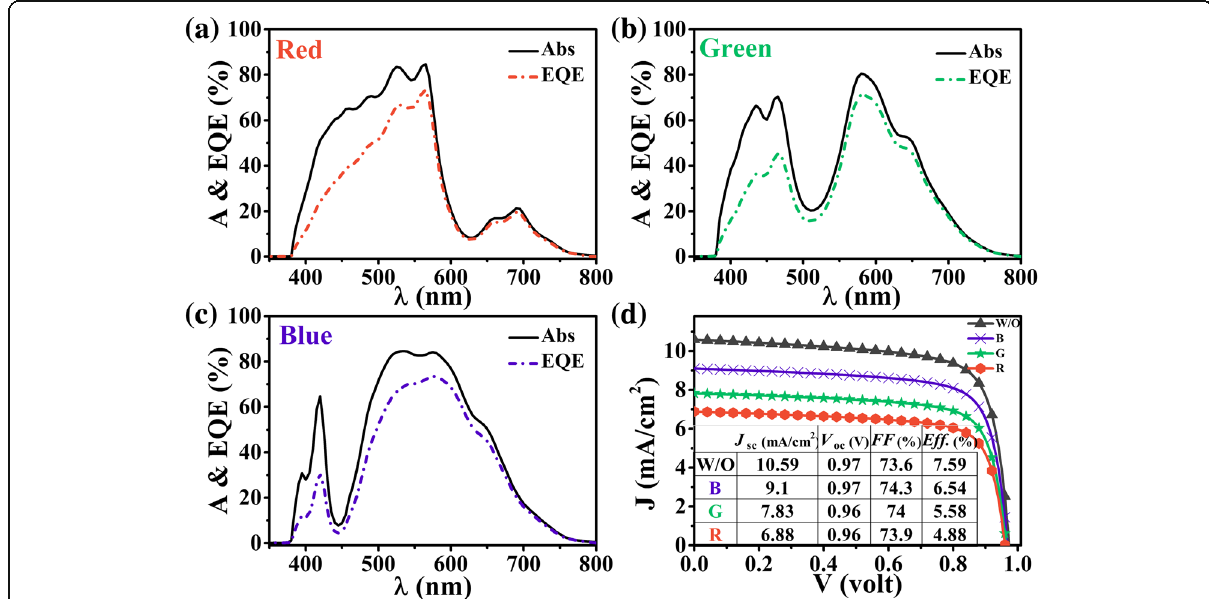
Fig. 3 Absorption and EQE spectra of the color-controlled a-Si:H SCs with color of a red, b green, and c blue. d IV curves of the designed a-Si:H SCs, where the original system without RGB design is included for reference. The inserted table shows the J SC , V OC , FF, and